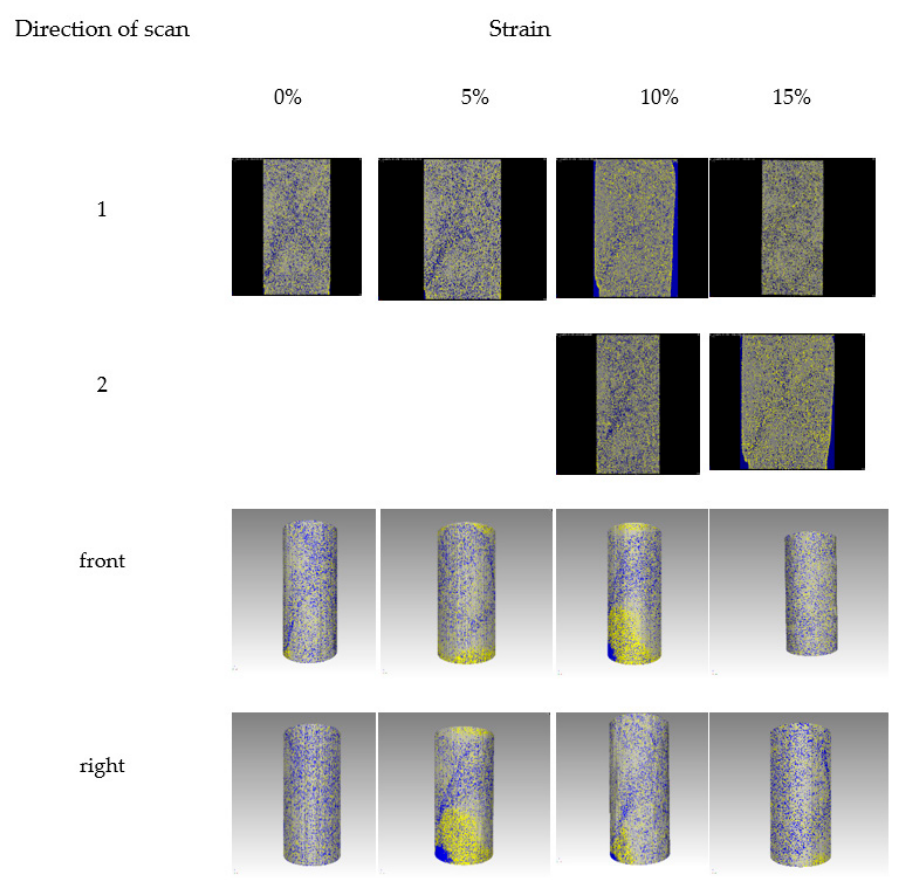
Figure 11. CT images with strain in different scan direction (Sh = 40%). ‘front’/’right’ and ‘1’/‘2’ mean the different directions of CT scan to the samples. The color of white indicates sand; the yellow indicates hydrate; the blue indicates gas.